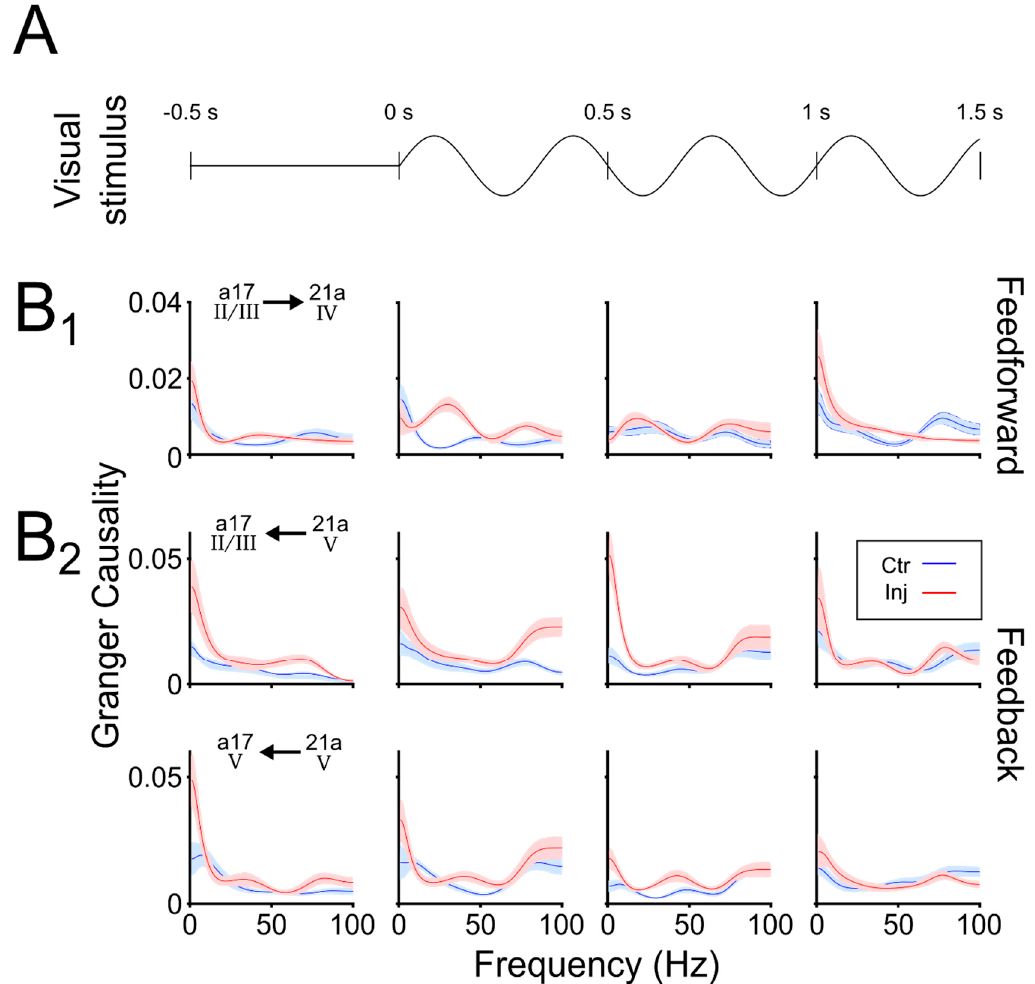
Figure 6. Granger causality of LFP signals for feedforward and feedback cortical coupling during the inactivation of the LPl. ( A ) Schematic 2D representation of the drifting grating stimulation over time. ( B1 ) Granger causality of the feedforward and ( B2 ) feedback coupling for windows of 500 ms before and during visual stimulation. Granger causality (GC) in the range of either alpha (6–13 Hz) or gamma band (25–40 Hz) synchronization. Shadow area represented the bootstrapping of random averages GC (1000 repetitions), to obtain a confidence interval at a threshold P = 0.05. Blue and red lines indicate GC before (Ctr) and during (Inj) pulvinar inactivation, respectively.